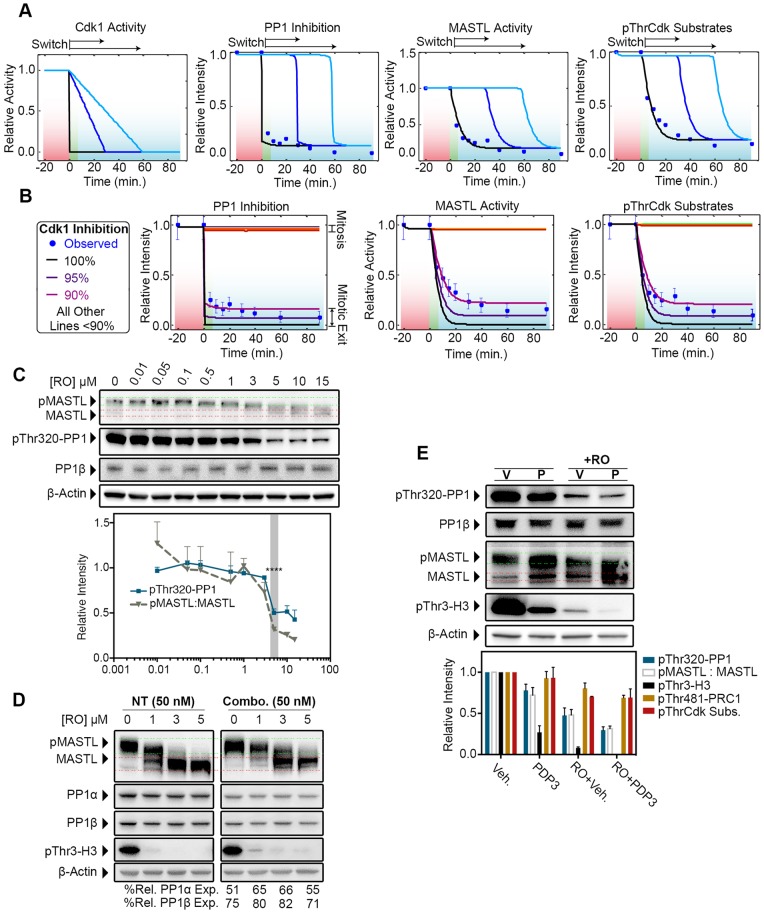
A threshold of Cdk1 activity and PP1 are required to trigger the mitotic exit switch. (A) Rate of Cdk1 inhibition from model a was changed to incorporate two different linear decay rates (blue lines), and subsequent effects on PP1 inhibition, MASTL activity and pThrCdk substrate dephosphorylation modelled. (B) Inhibition of Cdk1 was varied from 5 to 100% in 5% increments using model a. (C) Validation of Cdk1 bistability threshold. Whole-cell lysates that had been treated with RO3306 (RO) for 15 min were probed by western blotting for total PP1β, PP1 phosphorylated at Thr320 (pThr320-PP1) and MASTL. Shown are representative blots, and quantification was performed – the intensity is expressed relative to the protein level at time 0 min. Mean+s.e.m., n=3. MASTL activity was estimated by quantifying the ratio of phosphorylated MASTL (pMASTL) (green lines) to MASTL (red lines) (pMASTL:MASTL); bistability is highlighted (grey shading). ****P<0.0001 (ordinary one-way ANOVA). (D) HeLa cells that had been co-depleted of PP1α (25 nM) and PP1β (25 nM) (combo) or with non-targeting (NT, control) siRNA were synchronised, as per Fig. 1A, treated with increasing concentrations of RO3306 for 30 min and assessed by western blotting for knockdown efficiency, dephosphorylation of MASTL (band shift) and of PP1 substrate histone H3 (pThr3-H3). Values represent the amount of PP1α and PP1β remaining, relative to that with control treatments (%Rel. Exp.). n=2. (E) HeLa cells were synchronised as described in Fig. 1A but treated with the PP1-activating peptide PDP3 (40 μM, P) or vehicle (V, Veh) control for 3 h prior to harvest. Samples were treated with (+RO) or without 3 µM RO3306 for 30 min. Lysates were analysed by western blotting and quantified relative to vehicle (far left lane), for pThr320-PP1, total PP1β, MASTL, pThr3-H3 and β-actin [see Fig. S4B for PRC1 phosphorylated at Thr481 (pThr481-PRC1) and pThrCdk substrates (pThrCdk Subs)]; n=2.